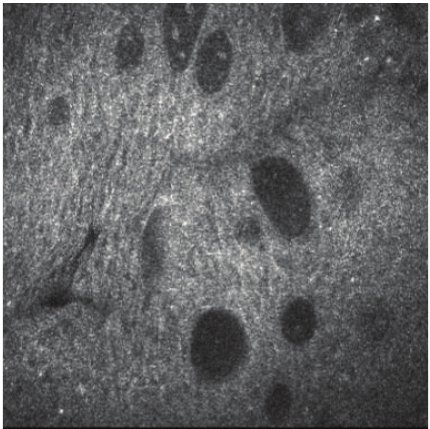
Figure 12: Conjunctival microcysts after